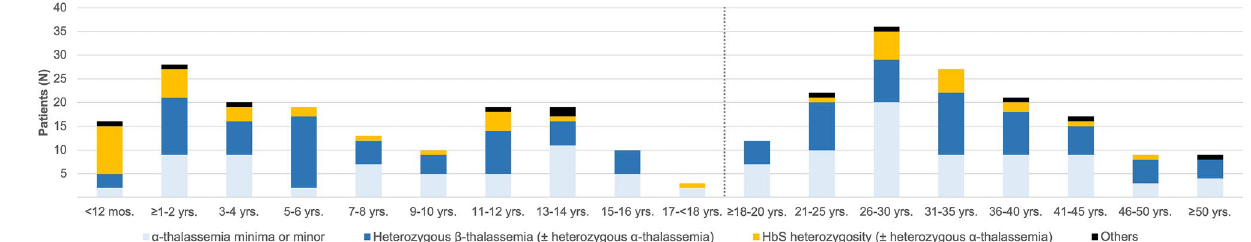
Figure 1. Age distribution of hemoglobinopathy carries identified at the Pediatric and Adult Hemoglobinopathy Outpatient Units (PAHOs) of the University Hospital Essen (Aug. 2018–Sept. 2021) (N = 310). Others (heterozygosity): α-thalassemia/Hb G-Philadelphia (N = 1), HbC (N = 2), HbD (N = 1), HbE (N = 1), Hb Presbyterian (N = 1), HbS/Hb Q-Iran (N = 1); delt-beta (δβ)-thalassemia (β-thalassemia) (N = 2), hereditary persistence of fetal hemoglobin (HPFH) (N = 1); mos., months; yrs.,